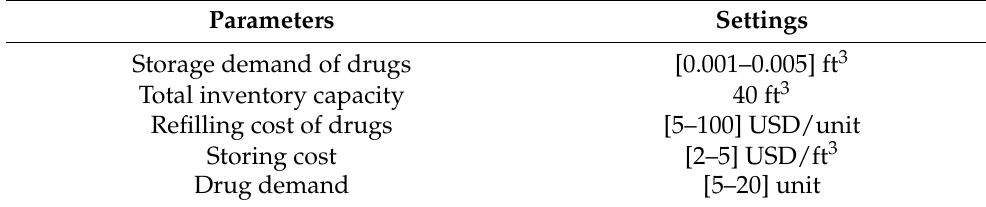
Table 2. Simulation